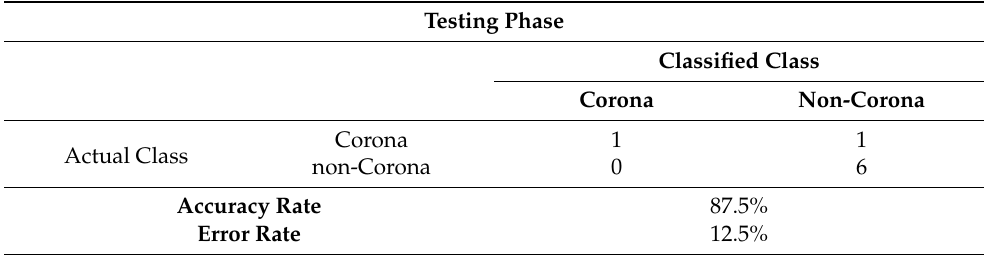
Table 9. Confusion matrix for testing phase—time domain corona fault classification.